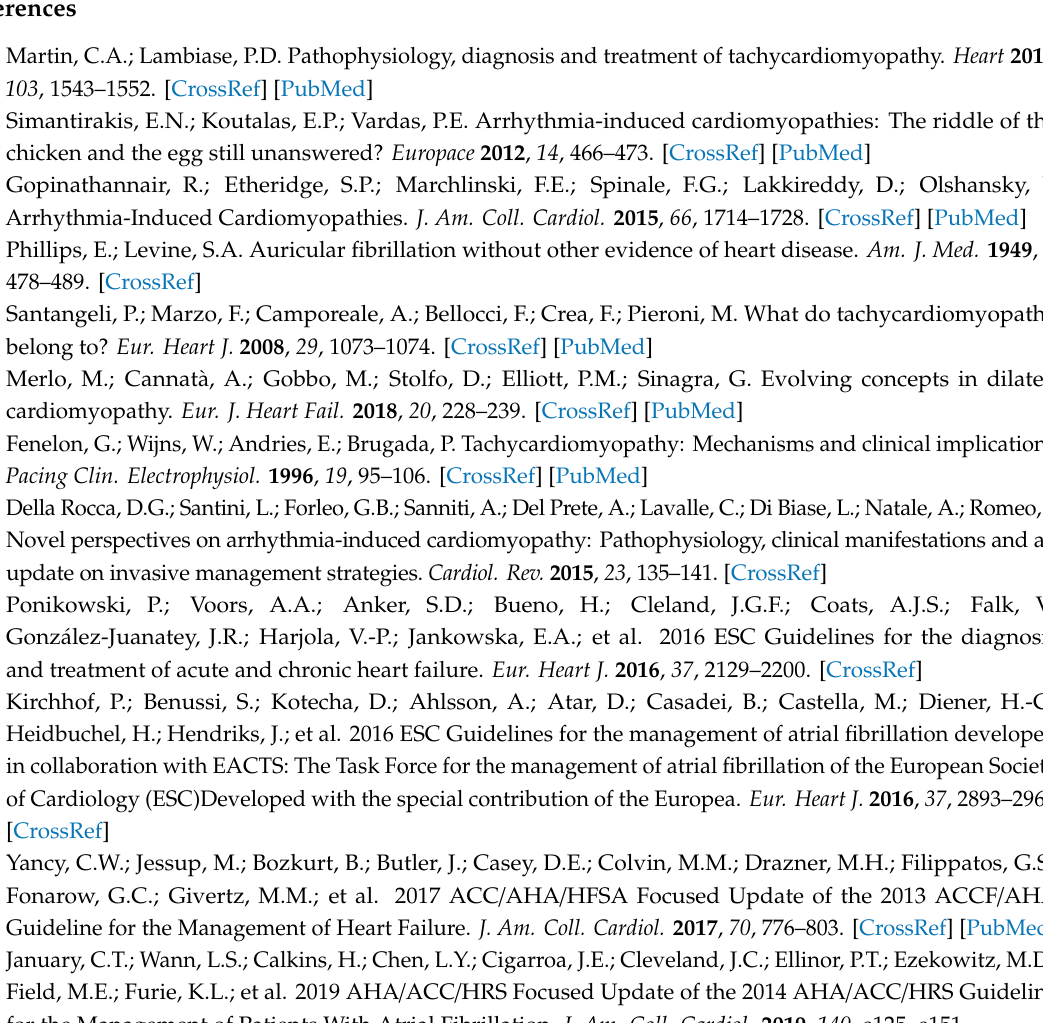
Figure S1a: splines curve detailing the association between heart rate at discharge and the risk or TCM, Figure S1b: splines curve detailing the association between BNP on admission and the risk or TCM, Figure S1c: splines curve detailing the association between heart rate at discharge and the risk of cardiovascular hospitalization, Figure S1d: splines curve detailing the association between LVEF at discharge and the risk of cardiovascular hospitalization, Table S1: STROBE Statement—checklist of items that should be included in reports of observational studies, Table S2: univariable and multivariable Cox-proportional hazard model for tachycardiomyopathy recurrence, Table S3: univariable and multivariable Cox-proportional hazard model for cardiovascular